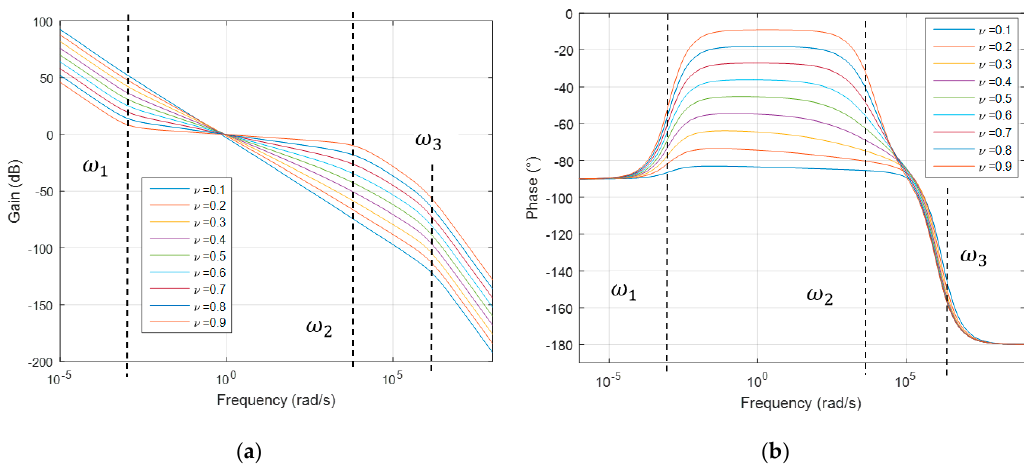
Figure 4. Gain ( a ) and phase ( b ) diagrams of H(s)/s for various values of ν .